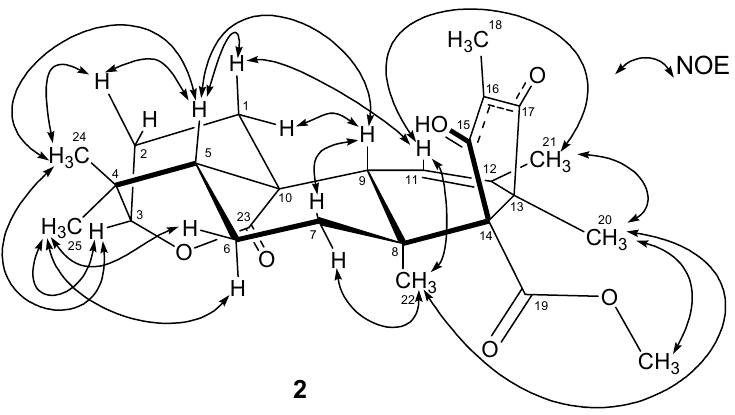
Figure 2. NOE connectivities in ( 2 ).